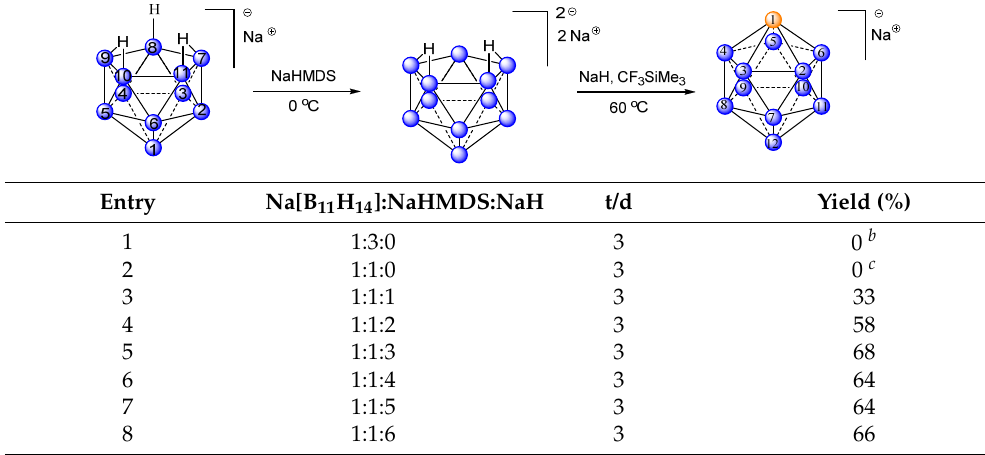
Table 2. Screening of the molar ratio of Na[B 11 H 14 ] to base a .